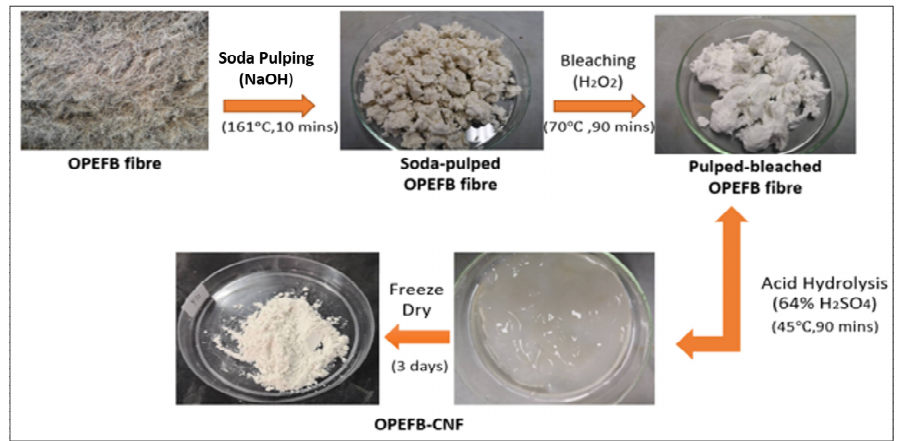
Figure 1. Isolation of cellulose nanofiber from oil palm empty fruits bunch.